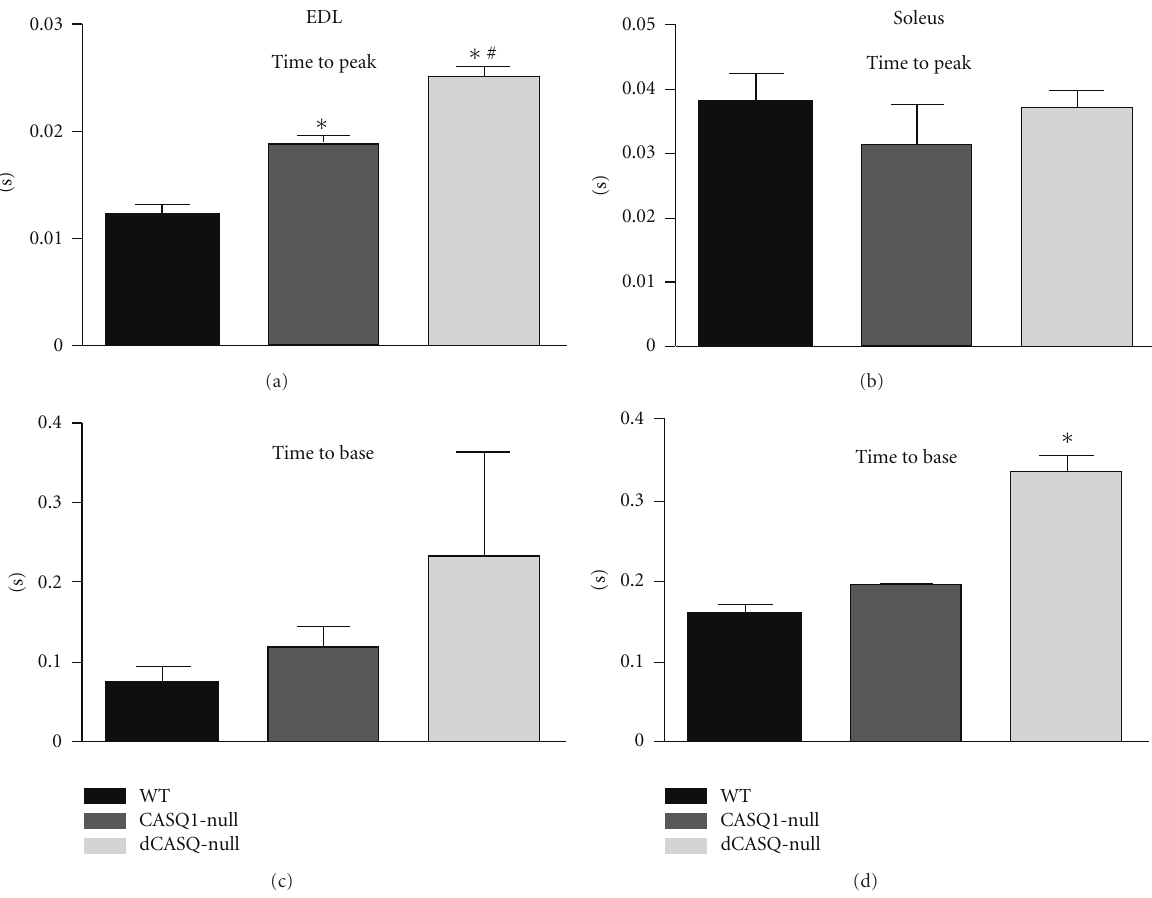
Figure 5: Ablation of CASQ isoforms resulted in prolongation of the twitch parameters in both EDL and Soleus . (a) and (b) Time to peak (i.e., from the stimulus to the tension peak) was prolonged in EDL from CASQ1-null, and even more in dCASQ-null, compared to WT. This e ff ect is not seen in Soleus. (c) and (d) On the other hand, time to base (i.e., from stimulus back to base line at the end of relaxation) was prolonged compared to WT in both EDL and Soleus muscles, more in dCASQ-null than in CASQ1-null mice (EDL: WT n = 8, CASQ1-null n = 10, dCASQ null n = 9, Soleus: WT n = 8, CASQ1-null n = 10, dCASQ null n = 10). ∗ Significantly di ff erent from WT; #significantly di ff erent from